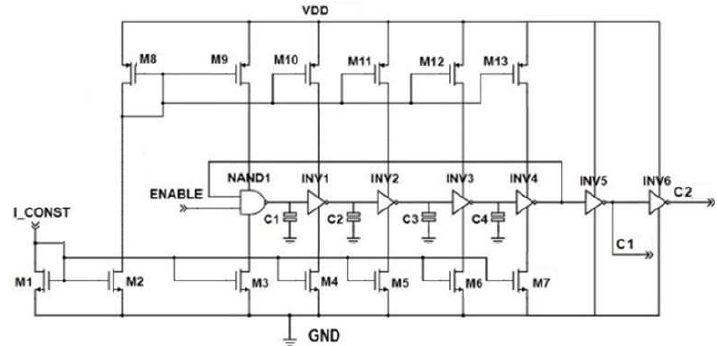
Figure 2. Classical current−starved ring VCO.